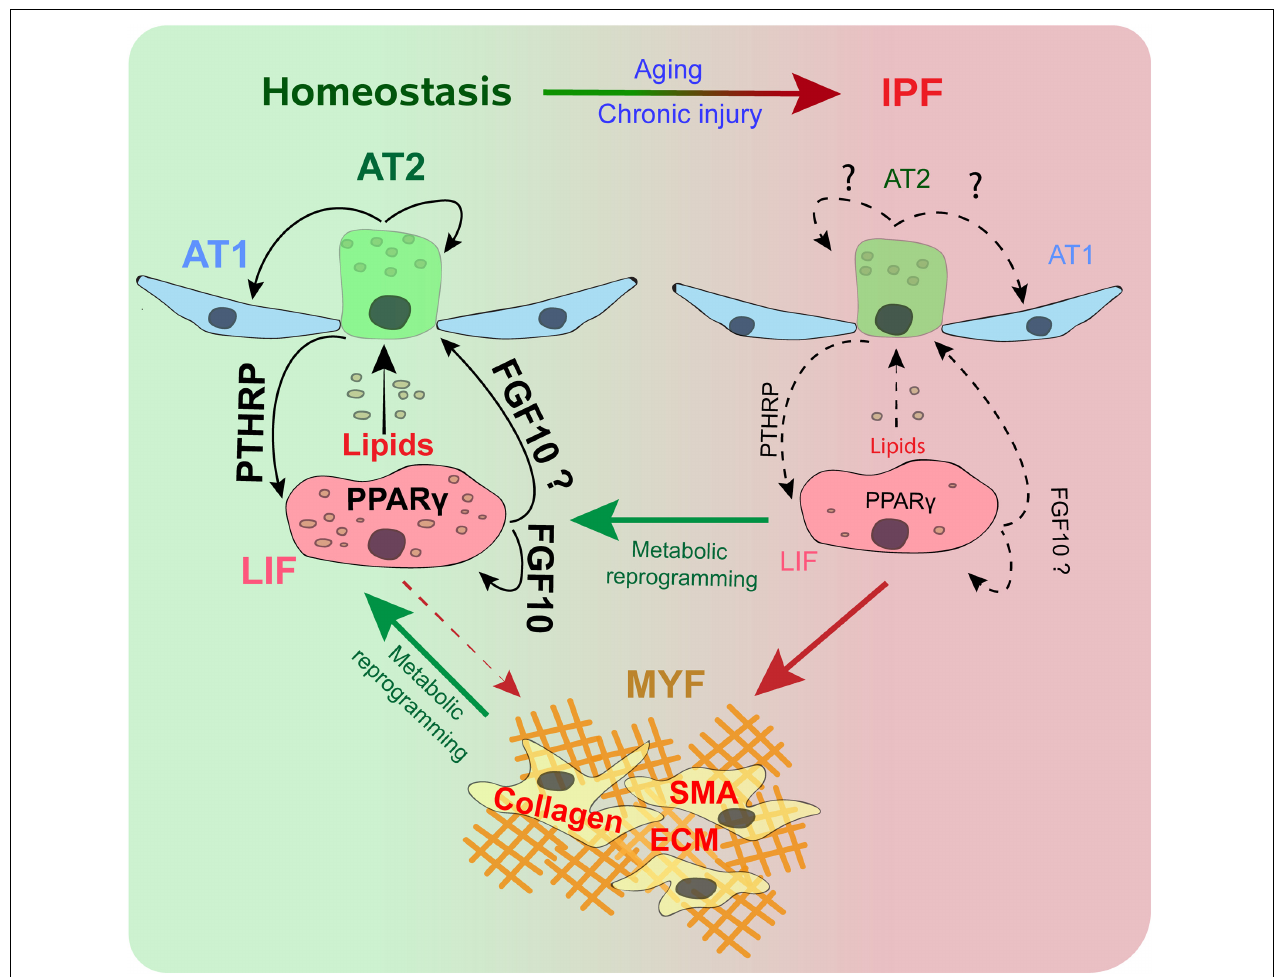
FIGURE 1 | Alveolar type 2 (AT2) and lipofibroblast (LIF) interaction during homeostasis and IPF. During homeostasis, a subset of AT2 cells helps in the renewal and maintenance of the AT2 and alveolar type 1 (AT1) pools. The PTHRP/PPAR γ axis is vital for lipid trafficking and surfactant production. FGF10 signaling maintains LIFs and acts as s stem cell niche for AT2. During IPF, AT2 cells senesce. Disruption of the PTHRP/PPAR γ axis and FGF10 leads to loss of LIFs. LIFs differentiate to smooth muscle actin (SMA) positive Myofibroblasts (MYF), with excessive extracellular matrix (ECM) deposition. Metabolic reprograming promotes the dedifferentiation of MYFs to LIFs, and helps retain the LIF